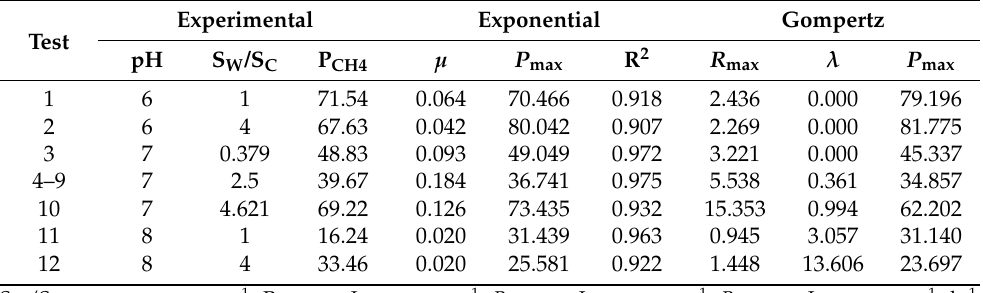
Table 3. Kinetic parameters obtained from the experimental tests of the anaerobic co-digestion of raw cheese whey and coffee pulp residues at 35 ◦